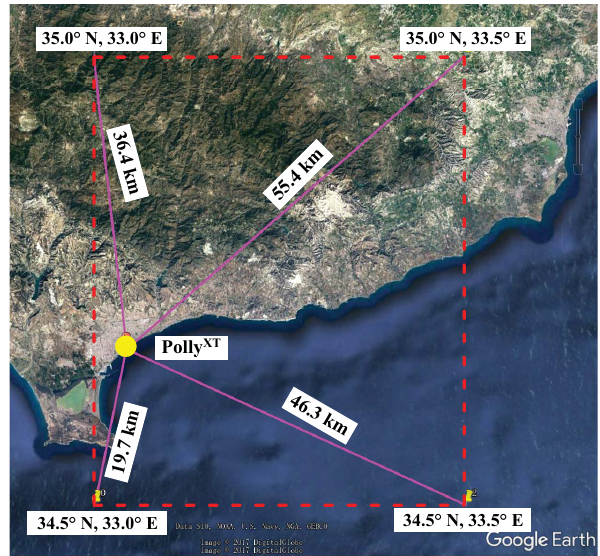
Figure 2. The nearest four GDAS grid points around the Polly XT location at Limassol, Cyprus, and the corresponding geographic in- formation. Map: Google Earth (October